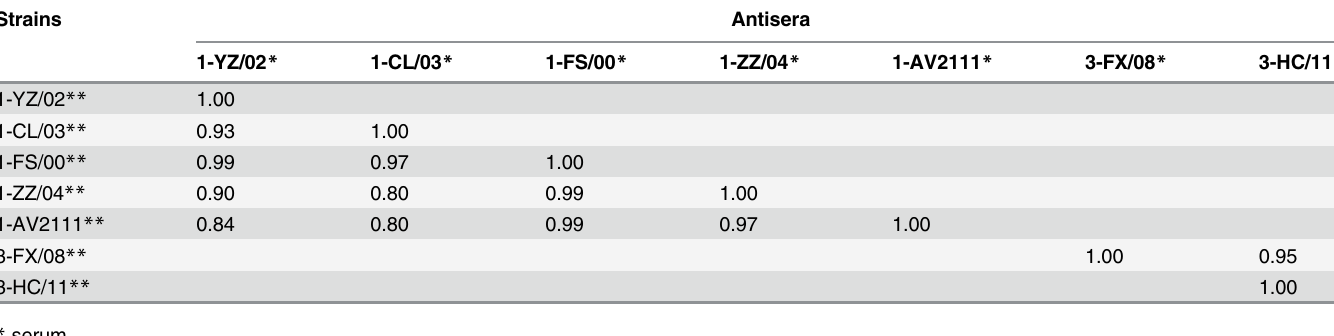
Table 4. Correlations Rates of Neutralization Assays testing DHAV-1 and DHAV-3 strains. Strains